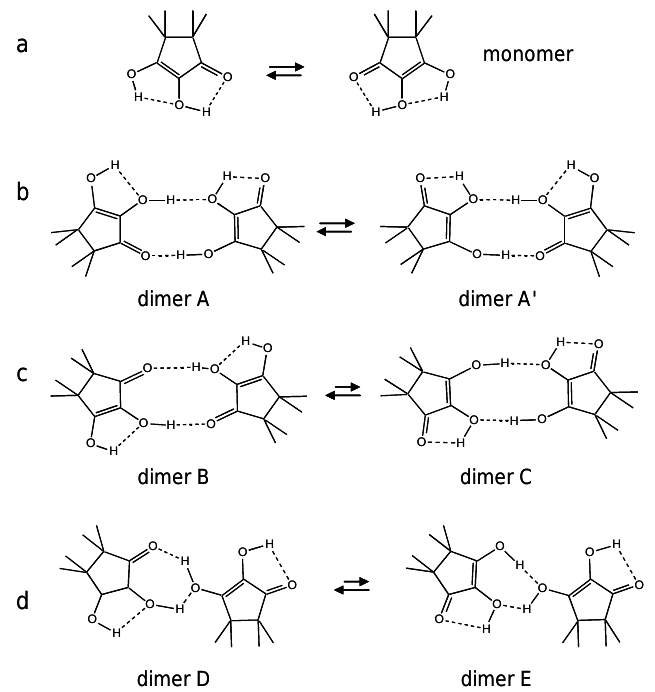
Figure 5. Potential intra- and intermolecular proton tautomerizations of TMRA in organic solvents. ( a ) Degenerate HH transfer of TMRA monomers. ( b ) Degenerate inter/intramolecular HHHH transfer in dimer A. ( c ) Non-degenerate inter/intramolecular HHHH transfer between dimers B and C. ( d ) Non-degenerate inter/intramolecular HHH transfer between dimers D and E.